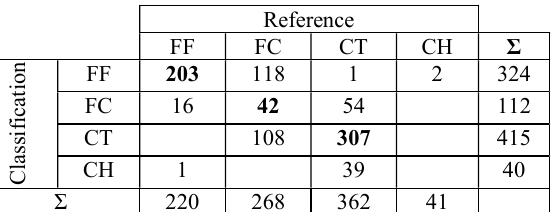
Table 6 . Matrix of confusion of the MD algorithm.